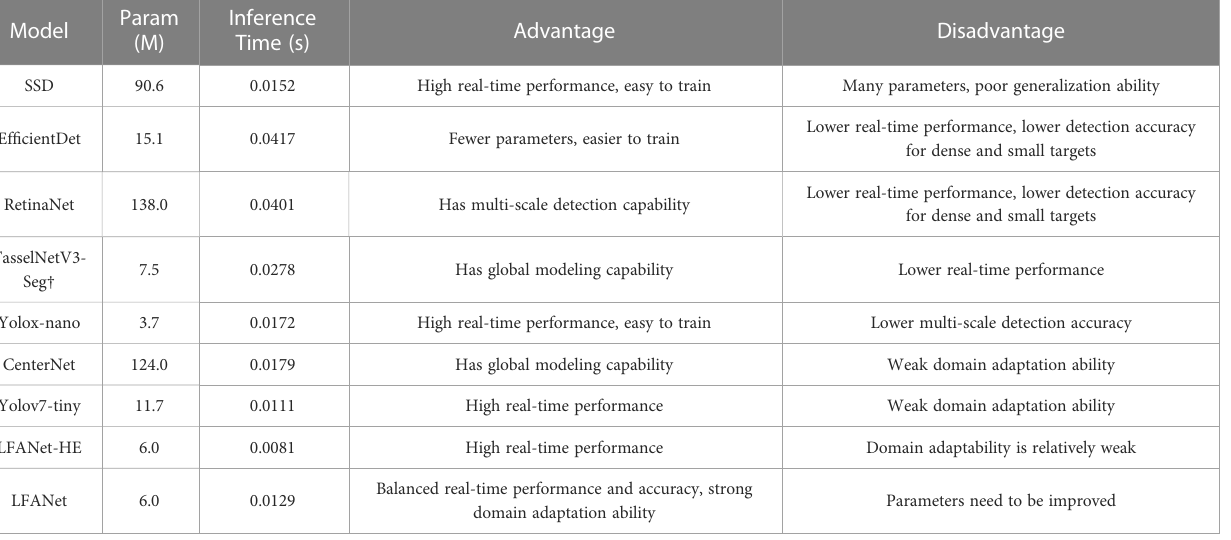
TABLE 7 Characteristics of different